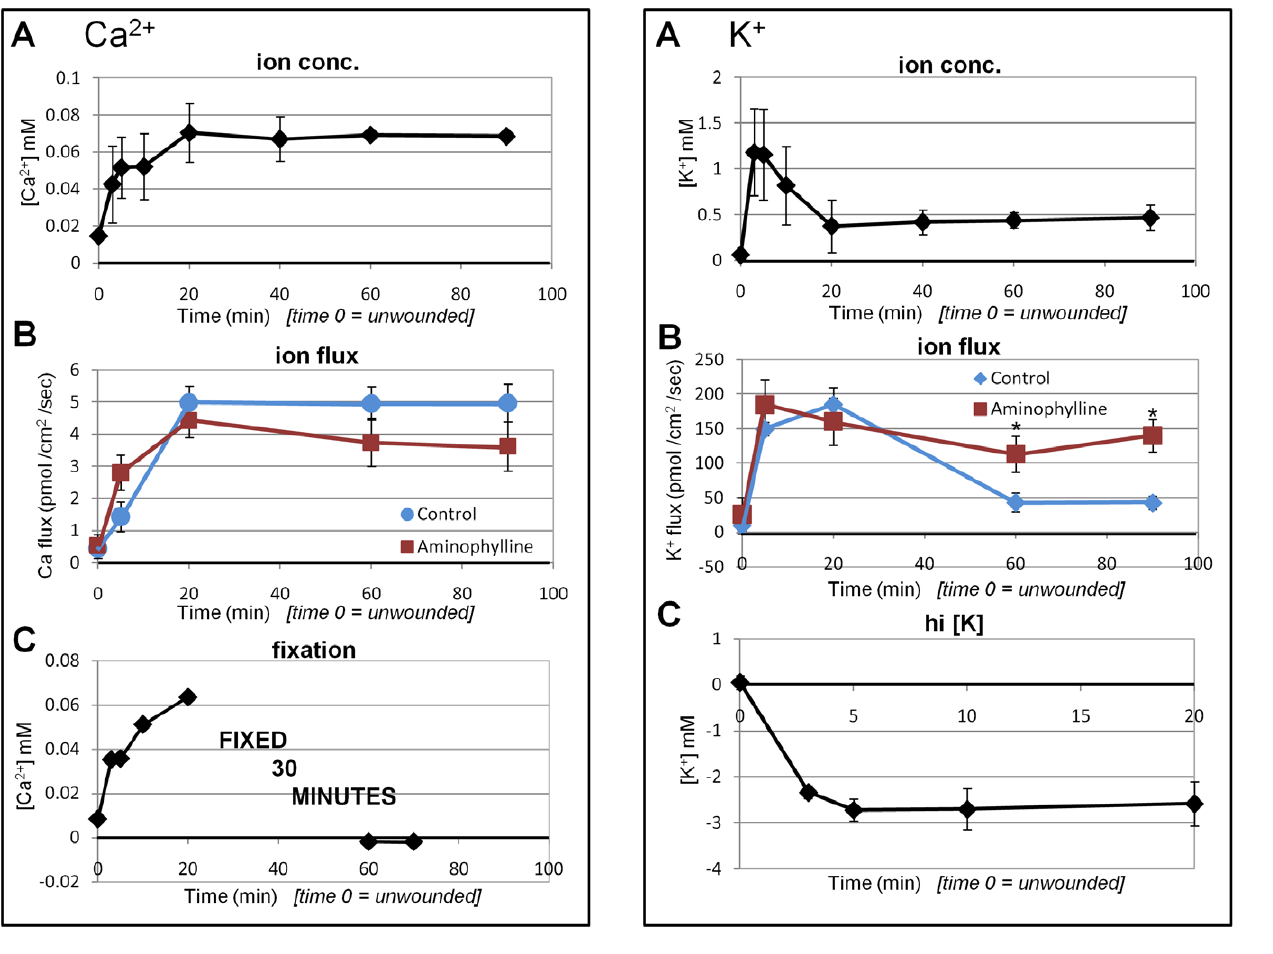
Figure 3. Calcium flux at corneal wounds. A. Ca 2 + concentra- tion. Calcium concentration at unwounded cornea was slightly above background (0.015 mM). After wounding, Ca 2 + concentraion increased until 20 min then plateaued. B. Ca 2 + flux. Unwounded cornea showed a small Ca 2 + efflux. After wounding, calcium efflux at the wound edge increased to reach a maximum value after 20 minutes. This efflux was maintained for up to 90 minutes. Aminophylline had no effect on Ca 2 + flux. C. Fixation. Calcium concentration was measured for 30 minutes to confirm normal efflux. The eye was then fixed. Subsequent measurements showed a drop in calcium concentration to almost zero, even lower than unwounded values. doi:10.1371/journal.pone.0017411.g003 Cruz, CA, USA; Cat # sc-16430), was used to label the protein (1 hour at room temperature). After washing in PBS, the samples were incubated with Cy3 conjugated secondary antibody (1:200,